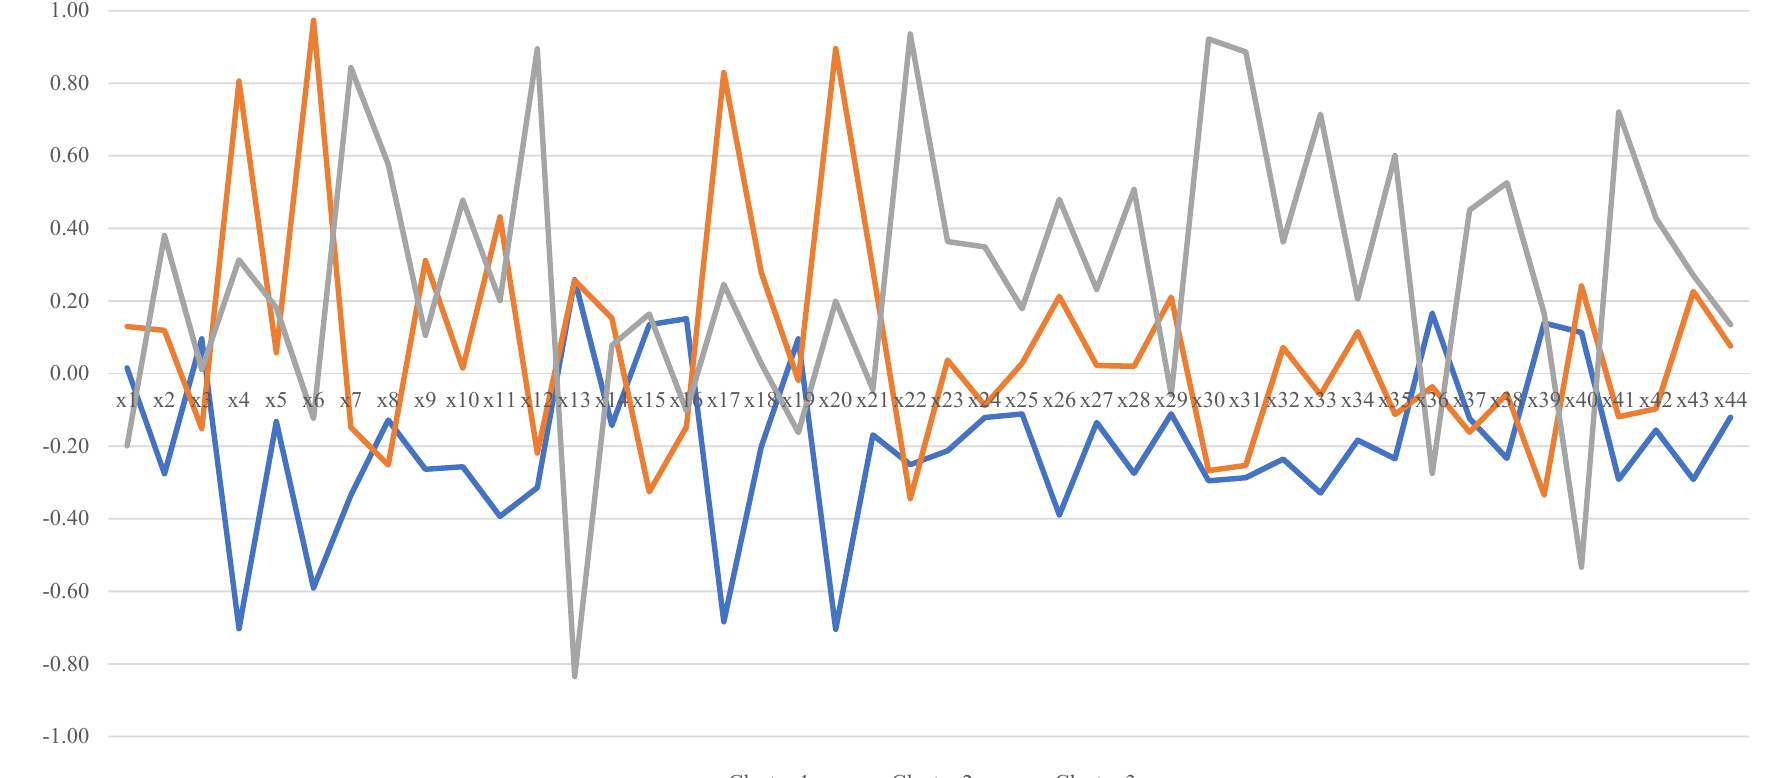
-1.00-0.80-0.60-0.40-0.200.000.200.400.600.801.00 Figure 4. Mean values of clusters for the classification of users of electric bicycles. Explanation: as in Table 1. Source: own elaboration on the basis of the questionnaire survey.